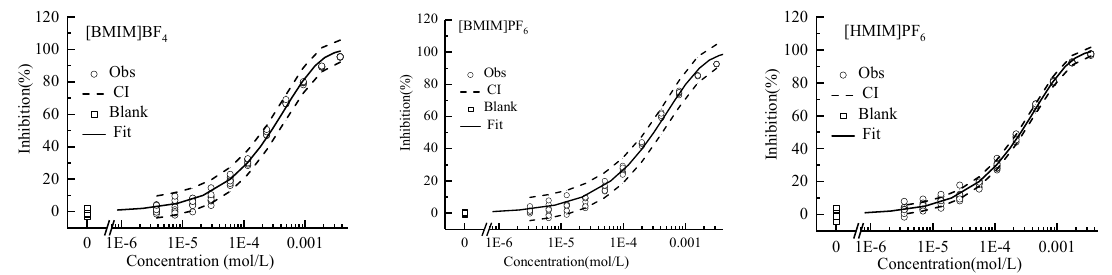
Figure 1. Concentration–response curves of single ILs inhibiting AChE. Square: blank control; Circle: observed data; Solid line: Weibull model fit; Dashed line: confidence interval.